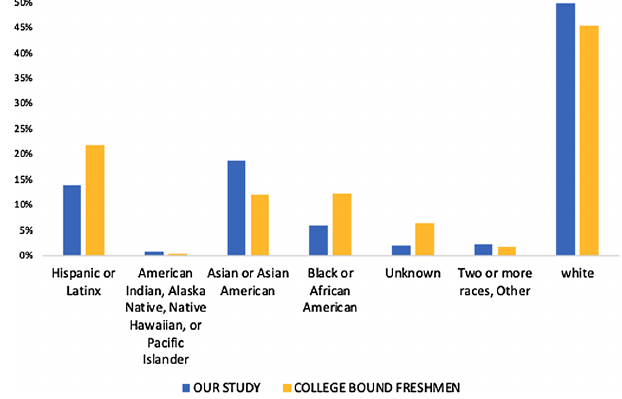
FIG. 3. Estimated racial and/or ethnic demographics of samples from our study (blue) versus all students taking the SAT in 2015 (orange). Blue bars are constructed from university-level dem- ographic data, weighted by sample size. Orange bars are con- structed from percentages cited in Ref.